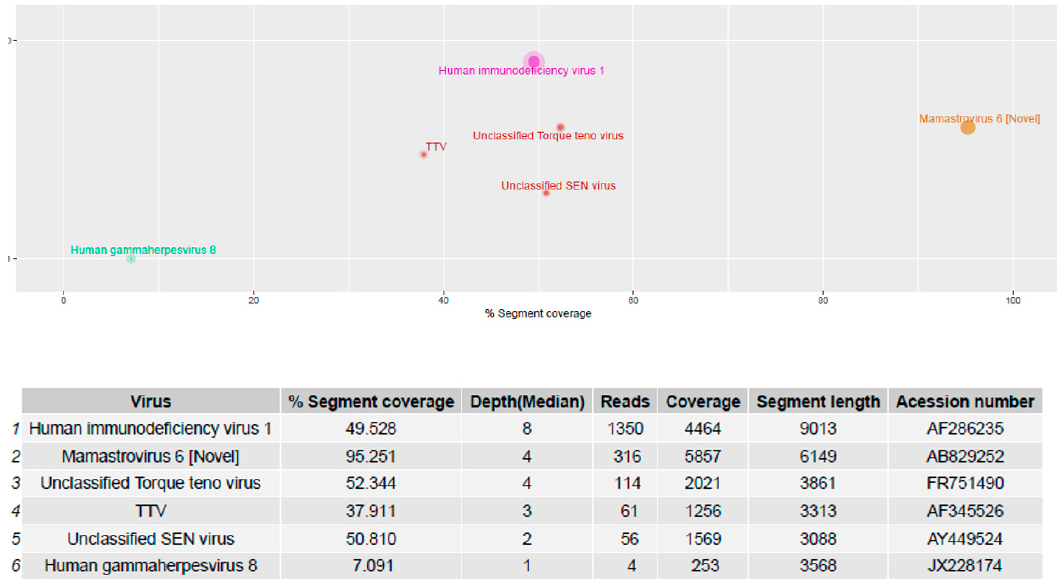
Figure 6. Human blood samples were sequenced and reads generated using the RNA protocol [9] were aligned to the Virosaurus database. The result is easy to interpret and confirms that the patient was positive for a novel human astrovirus, HIV-1 and HHV-8 sequences, as previously reported [23]. Top panel: 2D representation of detected sequences with %segment coverage in the X -axis, and depth (median) in Y -axis; bottom panel: raw data. Size of dots is relative to number of reads. Anellovirus (TTV) sequences were also detected. The Virosaurus hierarchy allows allocating reads to viral entities: at the level of virus (HIV-1, HHV-8, MastV-6) or higher (TTV). Unclassified SEN viruses are TTV-like genomes. Mamastrovirus (Novel) is a subtyping, allowing differentiating between novel (i.e., MLB and VA/HMO) and classical human astroviruses.